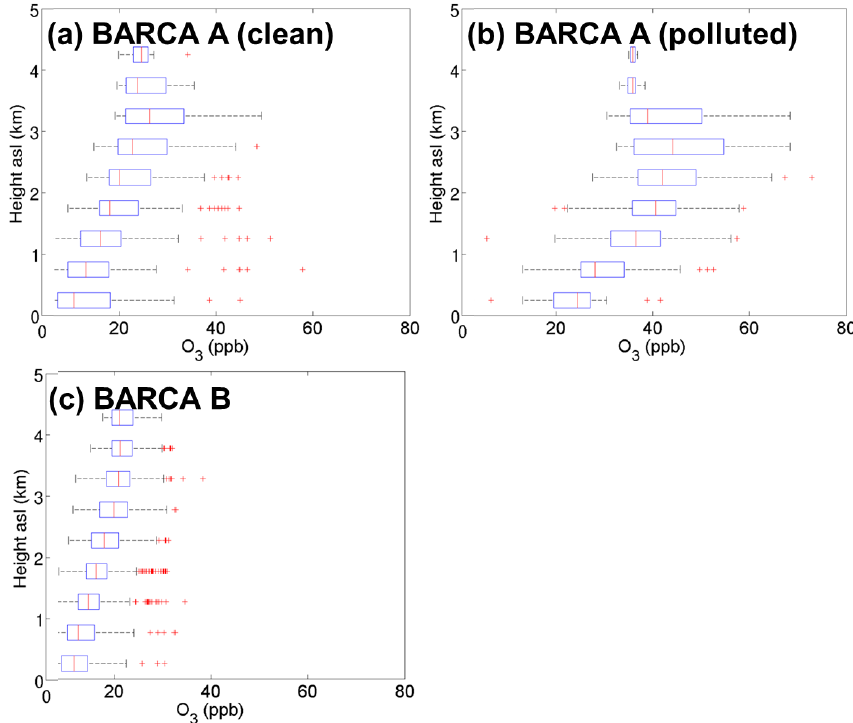
Figure 2. O 3 observations during (a) BARCA A, clean conditions (west, north, and around Manaus regions), (b) BARCA A, polluted conditions (east and south regions), and (c) BARCA B. The central mark is the median, the edges of the box are the 25th and 75th percentiles, the whiskers extend to the most extreme data points not considered outliers, and outliers are plotted individually as red plus signs. Values are drawn as outliers if their values exceed q 3 + w(q 3 − q 1 ) or are less than q 1 − w(q 3 − q 1 ) , where q 1 and q 3 are the 25th and 75th percentiles, respectively, and w is the maximum whisker length with the default value of 1.5. For normally distributed data, the whiskers encompass approximately the 2.7 to 99.3 percentiles.